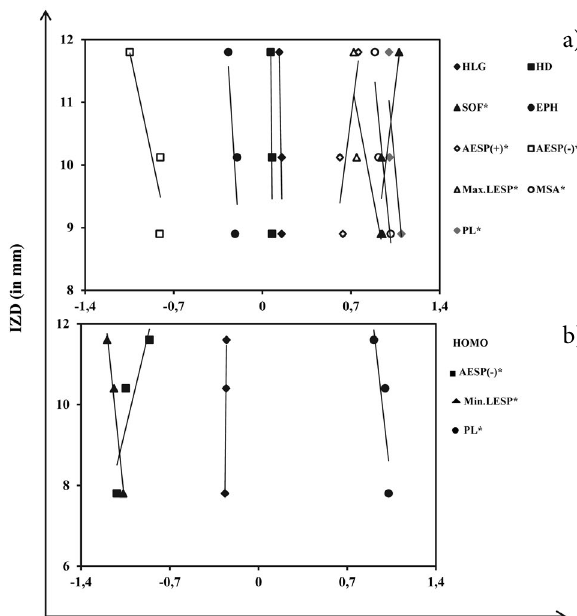
Figure 4. The correlation between descriptors and the IZD values of the ligands 4b , e , f and 4a , f , g against Gram-negative bacteria 1399 (a) and 1776 (b), respectively.